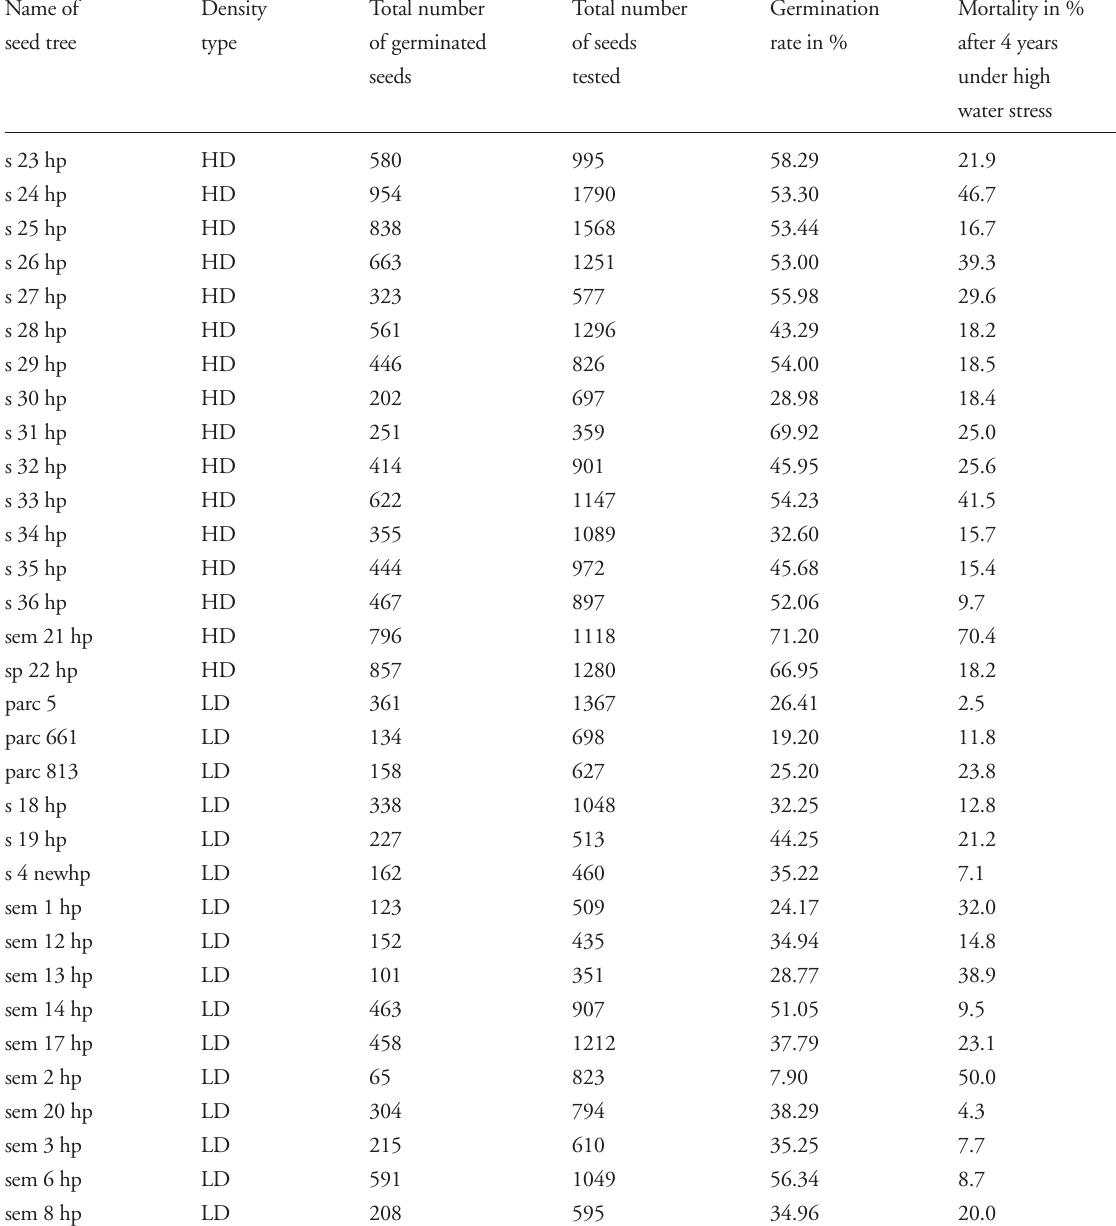
Table 2. Germination rate of the 32 seed lots tested according to stand density. Density type: HD = high density, LD = low density. Name